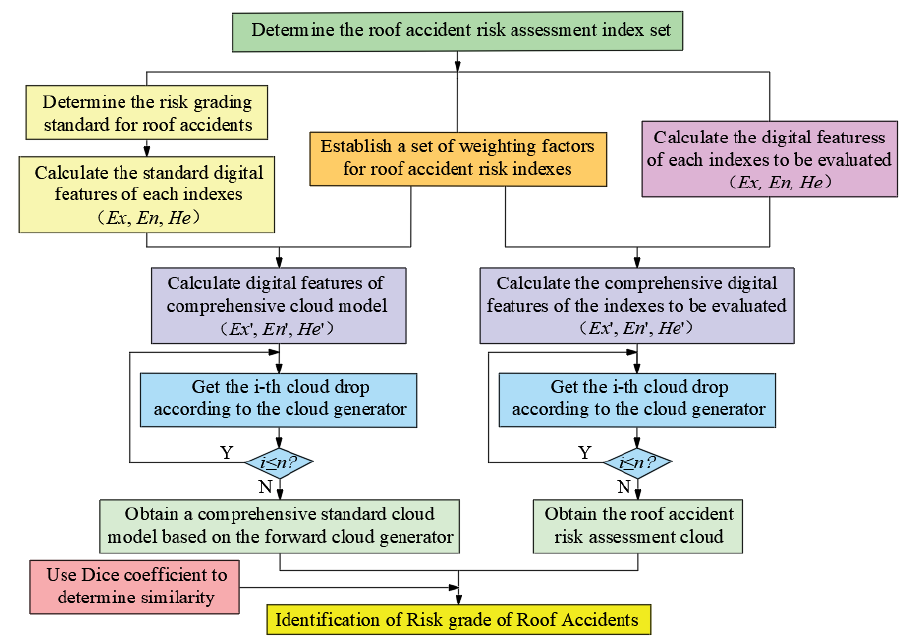
Figure 3. Risk evaluation framework of roof accidents in cloud model.